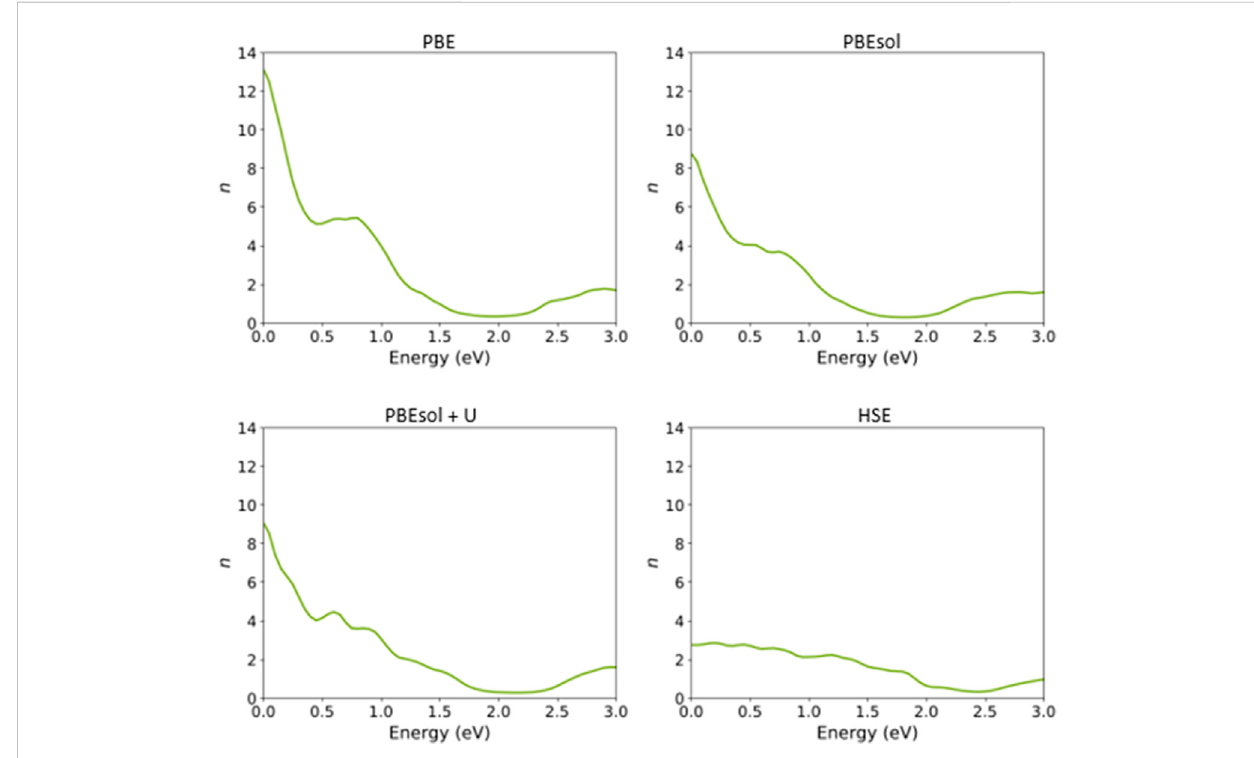
FIGURE 10 Refractive index of the VO 2 (M) nanostructure as a function of energy (eV), as predicted by the PBE, PBEsol, PBEsol + U, and HSE